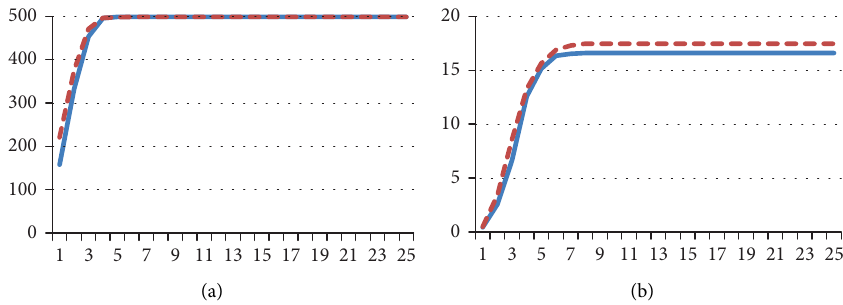
Figure 6: Comparison of the difusion of NEV with a diferent price: (a) difusion of information and (b) difusion of products (the blue line represents experiment A and the red line represents experiment F ).